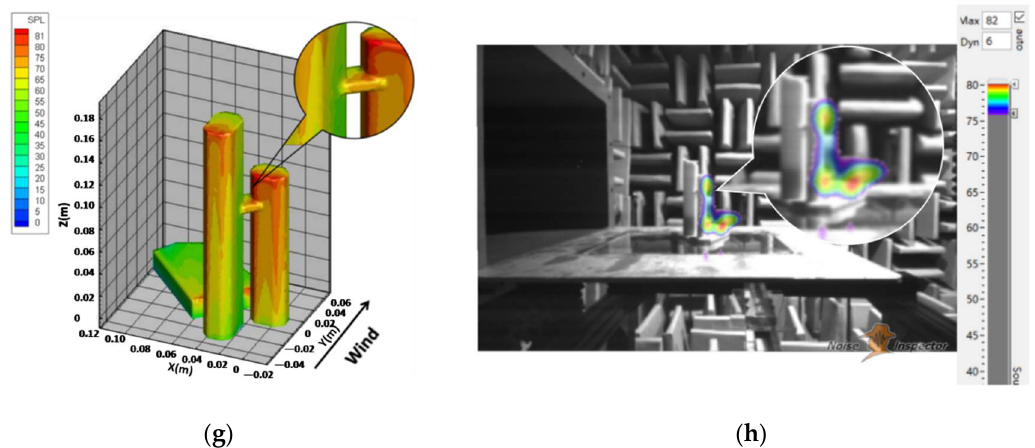
Figure 9. Comparison of experimental and simulated sound source localization at the wind angle of 90°. ( a ) 25 m/s numerical simulation; ( b ) 25 m/s wind tunnel experiment; ( c ) 30 m/s numerical simulation; ( d ) 30 m/s wind tunnel experiment; ( e ) 35 m/s numerical simulation; ( f ) 35 m/s wind tunnel experiment; ( g ) 40 m/s numerical simulation; ( h ) 40 m/s wind tunnel experiment.